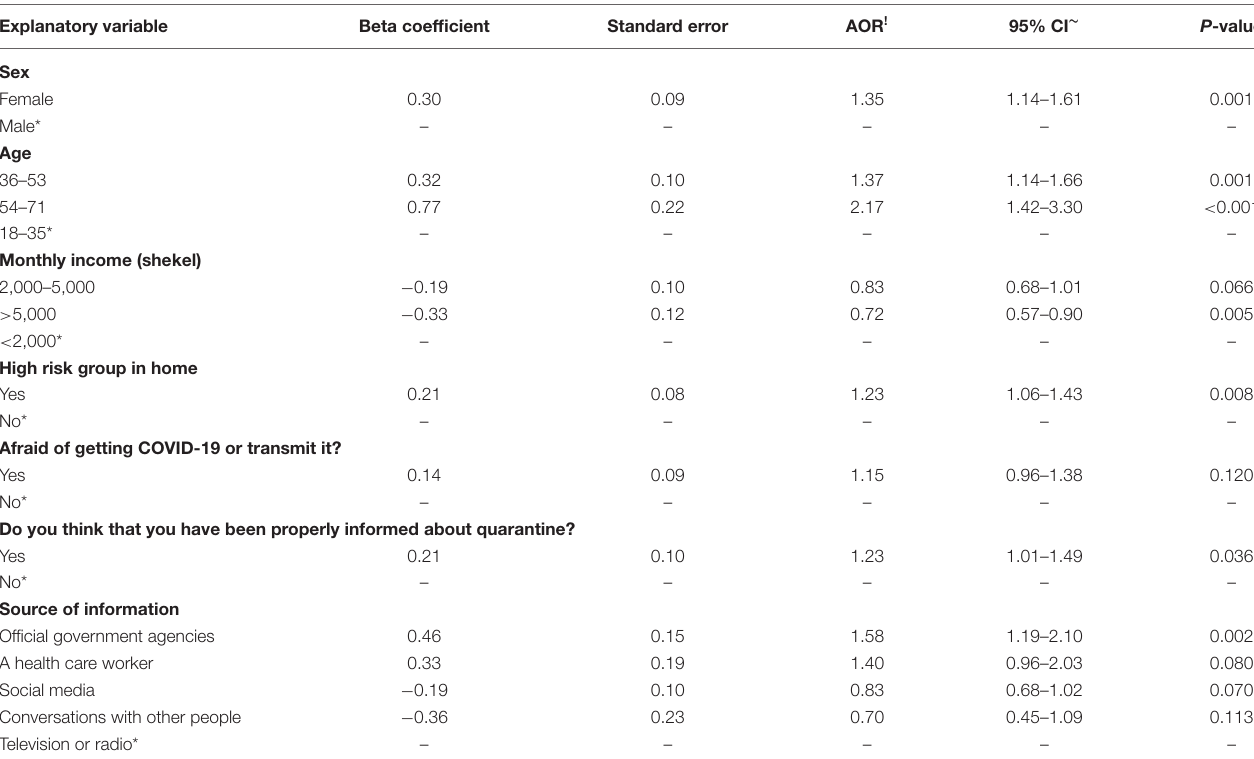
TABLE 4 | Multivariate logistic regression model for factors associated with in-home precautions adherence ( N =